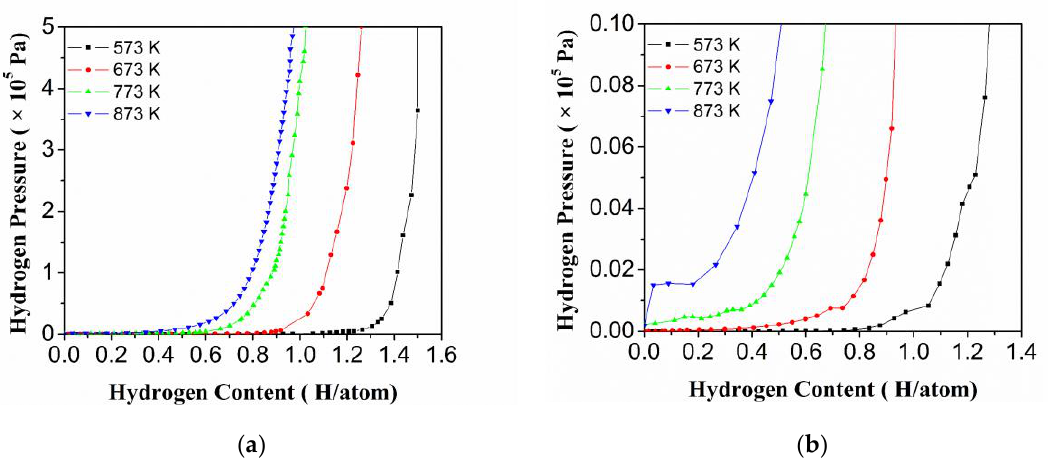
Figure 2. ( a ) Hydrogen absorption Pressure–composition isotherm (PCI) curve of Ti 0.20 Zr 0.20 Hf 0.20 Nb 0.40 HEA at different temperatures; ( b ) magnified image of the denoted area with dotted line in ( a ). Table 1. The plateau pressures and hydrogen storage capacities of Ti 0.20 Zr 0.20 Hf 0.20 Nb 0.40 HEA